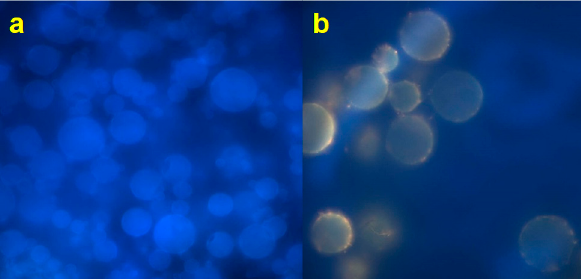
Figure 5. Fluorescence (FM) images of spray dried unloaded (EP 3 , ( a ) and loaded (AJEP 3 , ( b )) microparticles.